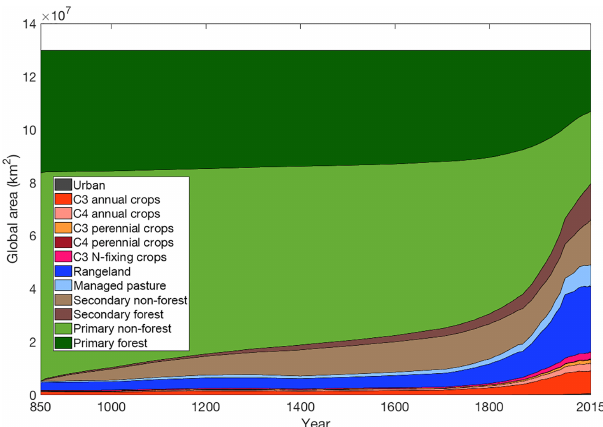
Figure 5. Evolution of various types of land cover and land use changes over the pre-industrial